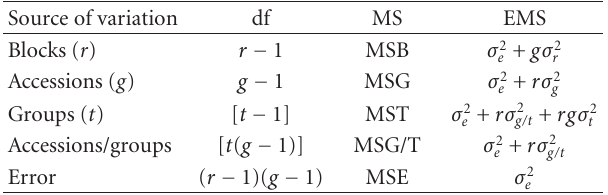
Table 3: ANOVA showing source of variation, degrees of freedom, means square, and error mean